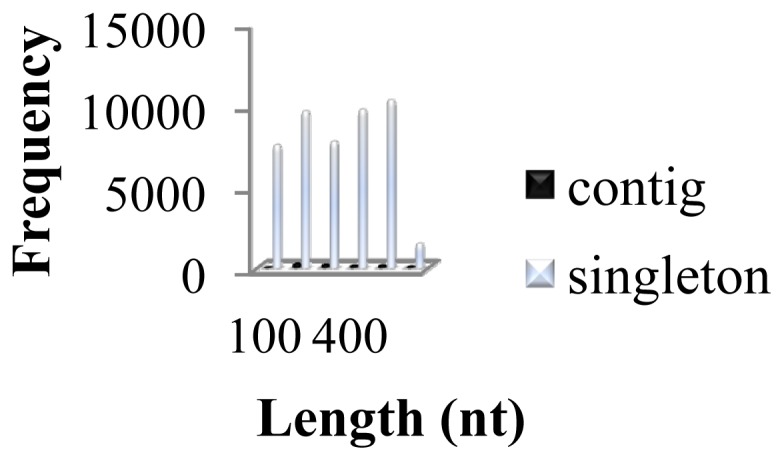
Summary of H. siamensis 454 pyrosequencing sequences.